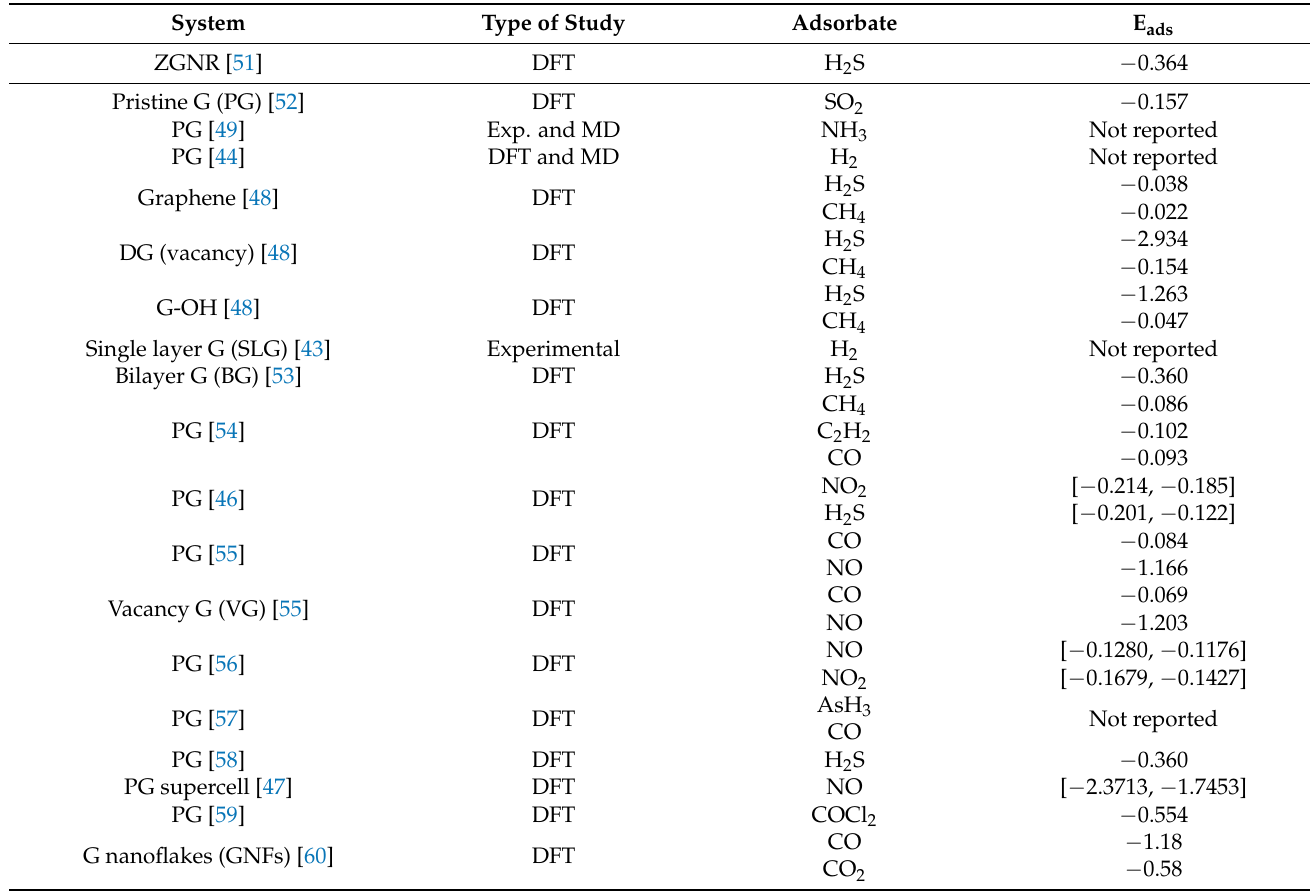
Table 2. Summary of adsorption energies E ads (in eV) for different non-metallic doped graphene systems and adsorbates. The type of study is also